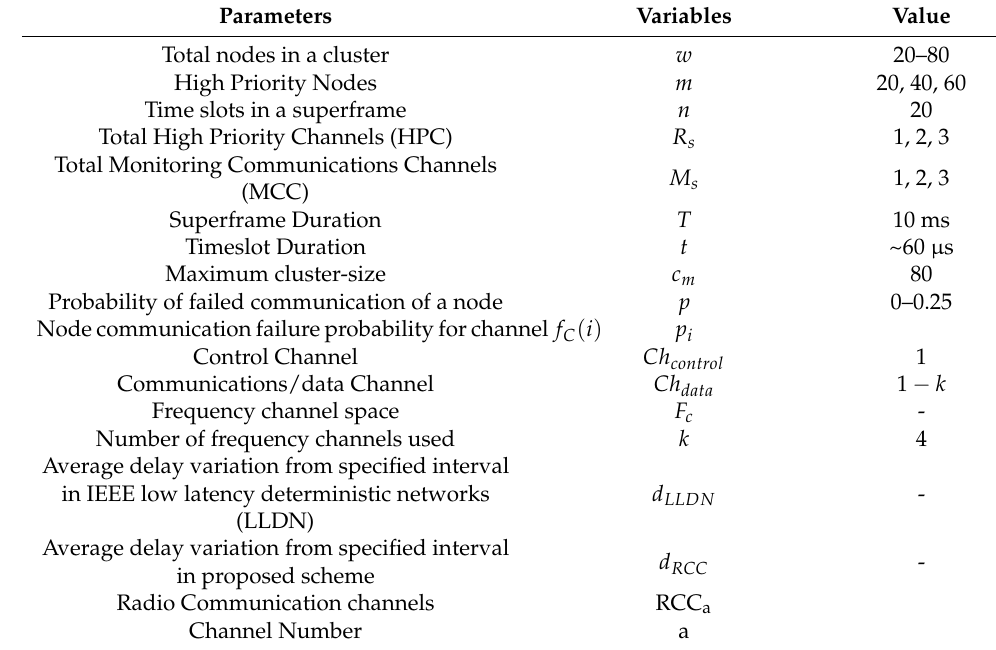
Table 1. Description of frequently used variables in the proposed IoT